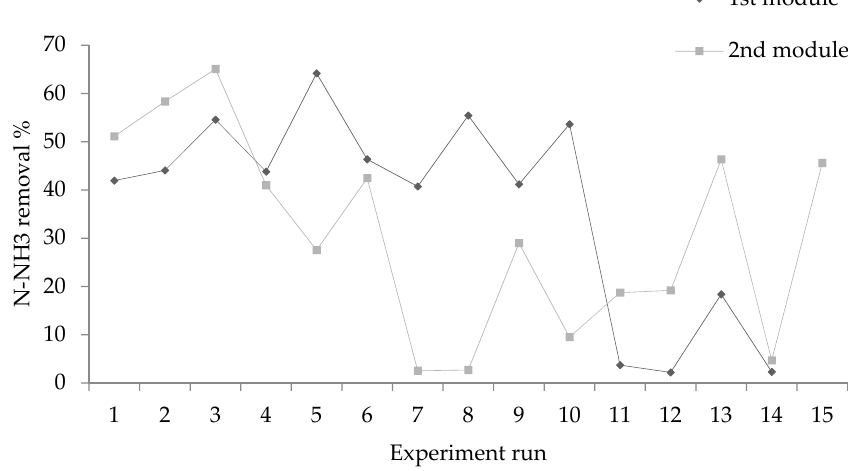
Figure 6. Performance of 1st and 2nd PTFE generation module (Flow feed side 0.05–1 L/h, permeate flow rate 0.05–0.5 L/h, pressure 0.5 Bar and temperature 50 °C).